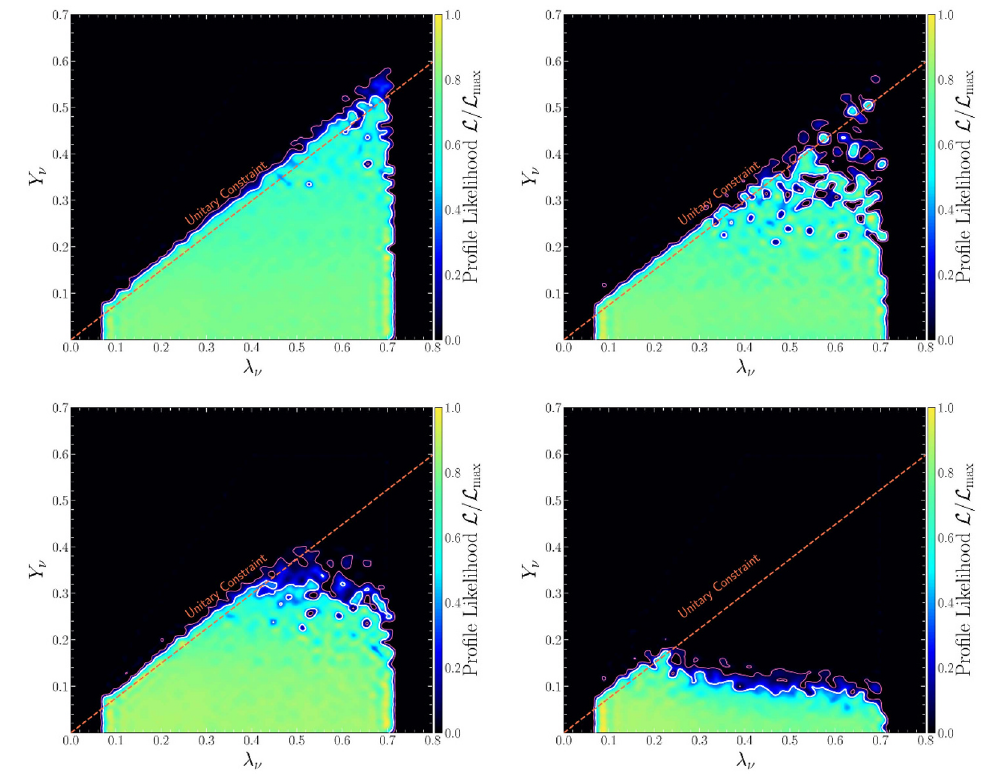
Figure 8 . Same as figure 3, but for the massive h s scenario defined in table